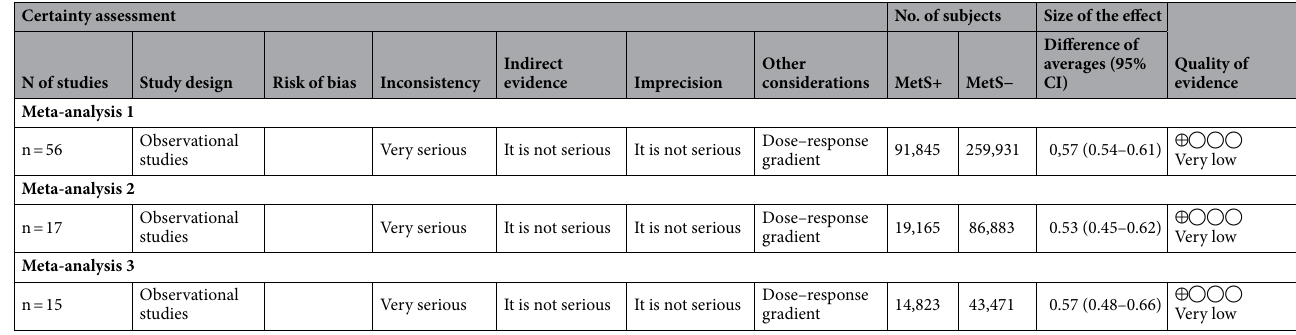
Table 2. Evidence profile with GRADE pro for the three meta-analyses. MetS metabolic syndrome, CI confidence